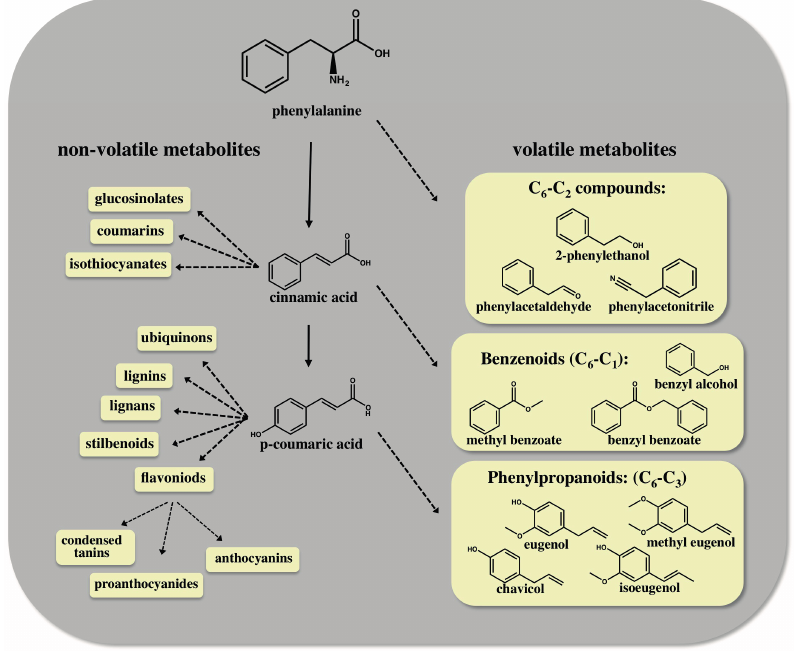
Figure 1. Schematic diagram of the phenylpropanoid/benzenoid biosynthetic pathway in plants. Phenylalanine, which is synthesized in the plastid through the shikimate and aromatic amino acids biosynthetic pathways, is the precursor for both volatile (right hand side) and non-volatile (left hand side) specialized metabolites. The chemical structure of representative volatile compounds that contribute to the aroma and flavor of flowers and fruits is shown. Dashed arrows represent several enzymatic